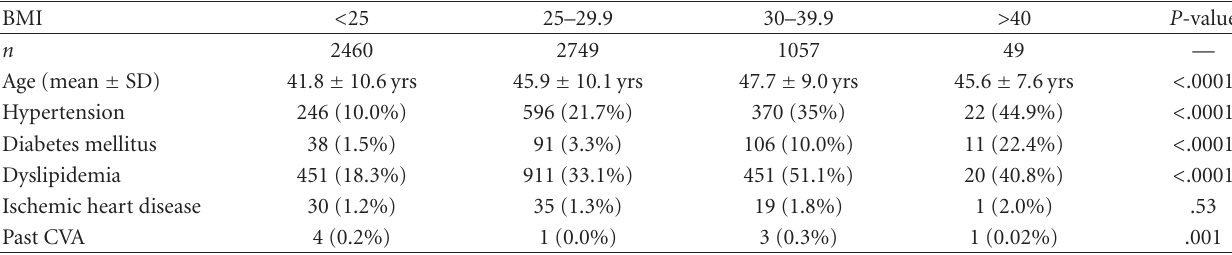
Table 1: Clinical characteristics of subjects for platelet count analysis stratified by BMI.